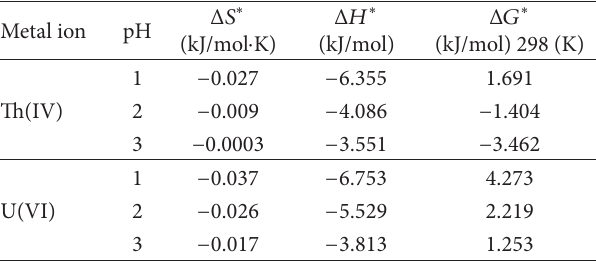
T 9: ermodynamic functions for orium(IV) and Ura-